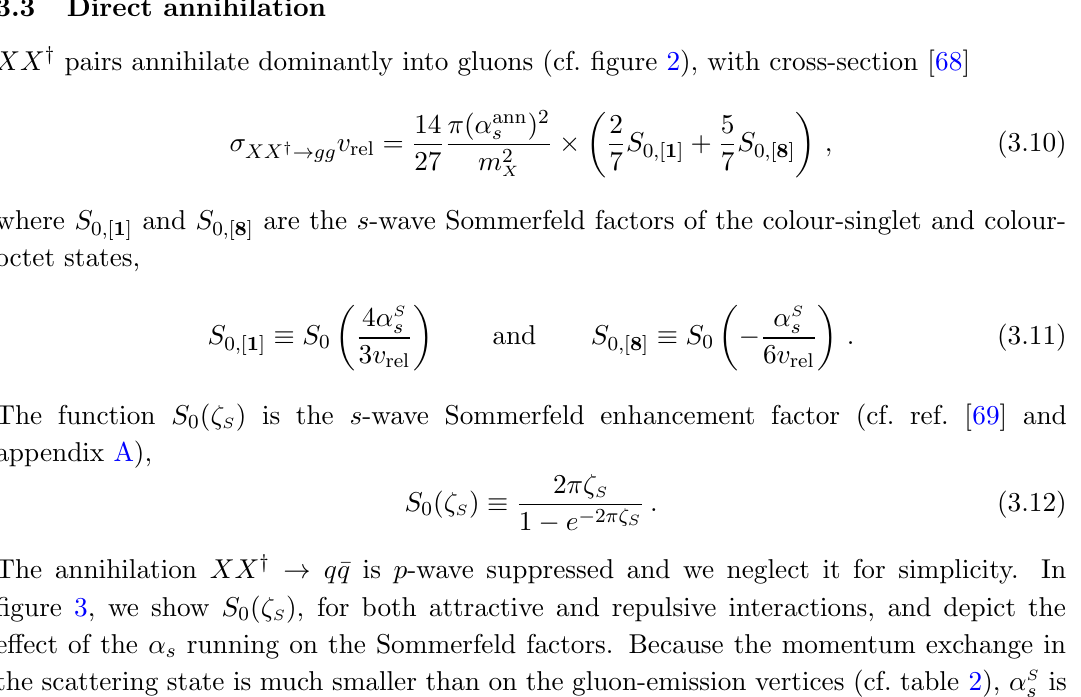
Figure 2. XX y annihilation into